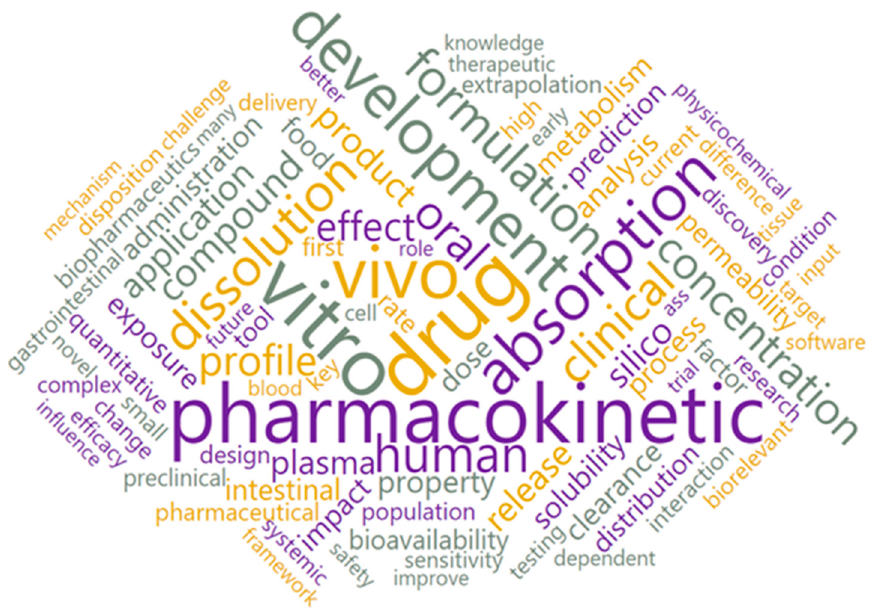
Figure 18. Word cloud for topic